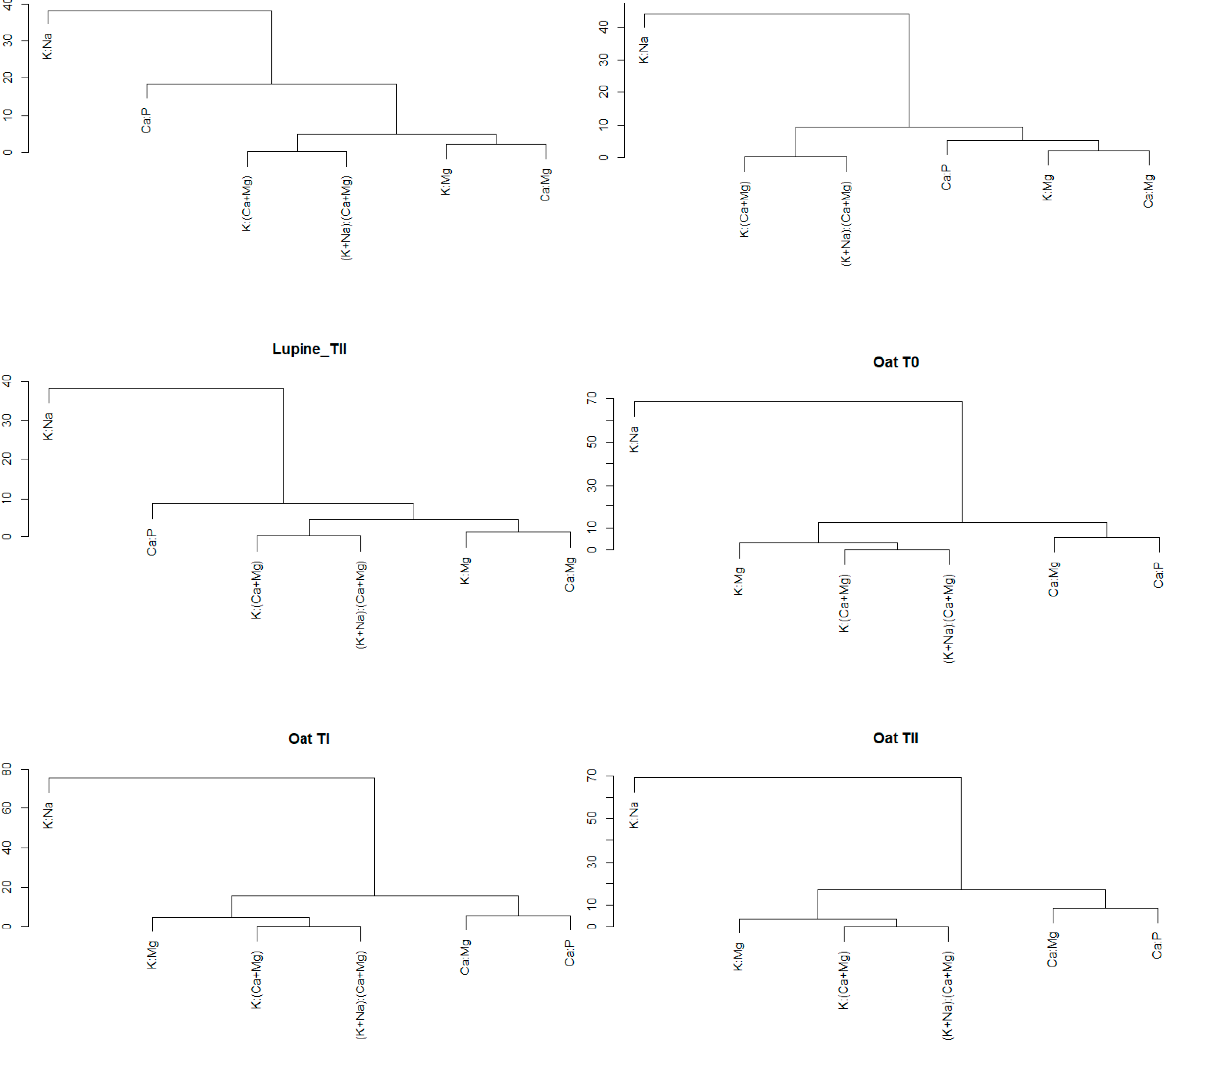
Figure 2. Dendrograms for values Ca:Mg, Ca:P, K:(Ca+Mg), (K+Na):(Ca+Mg), K:Mg and K:Na ratios in lupine and oat grown on soils: T0—control soil, TI—soil with compost addition and TII—soil with FA addition.